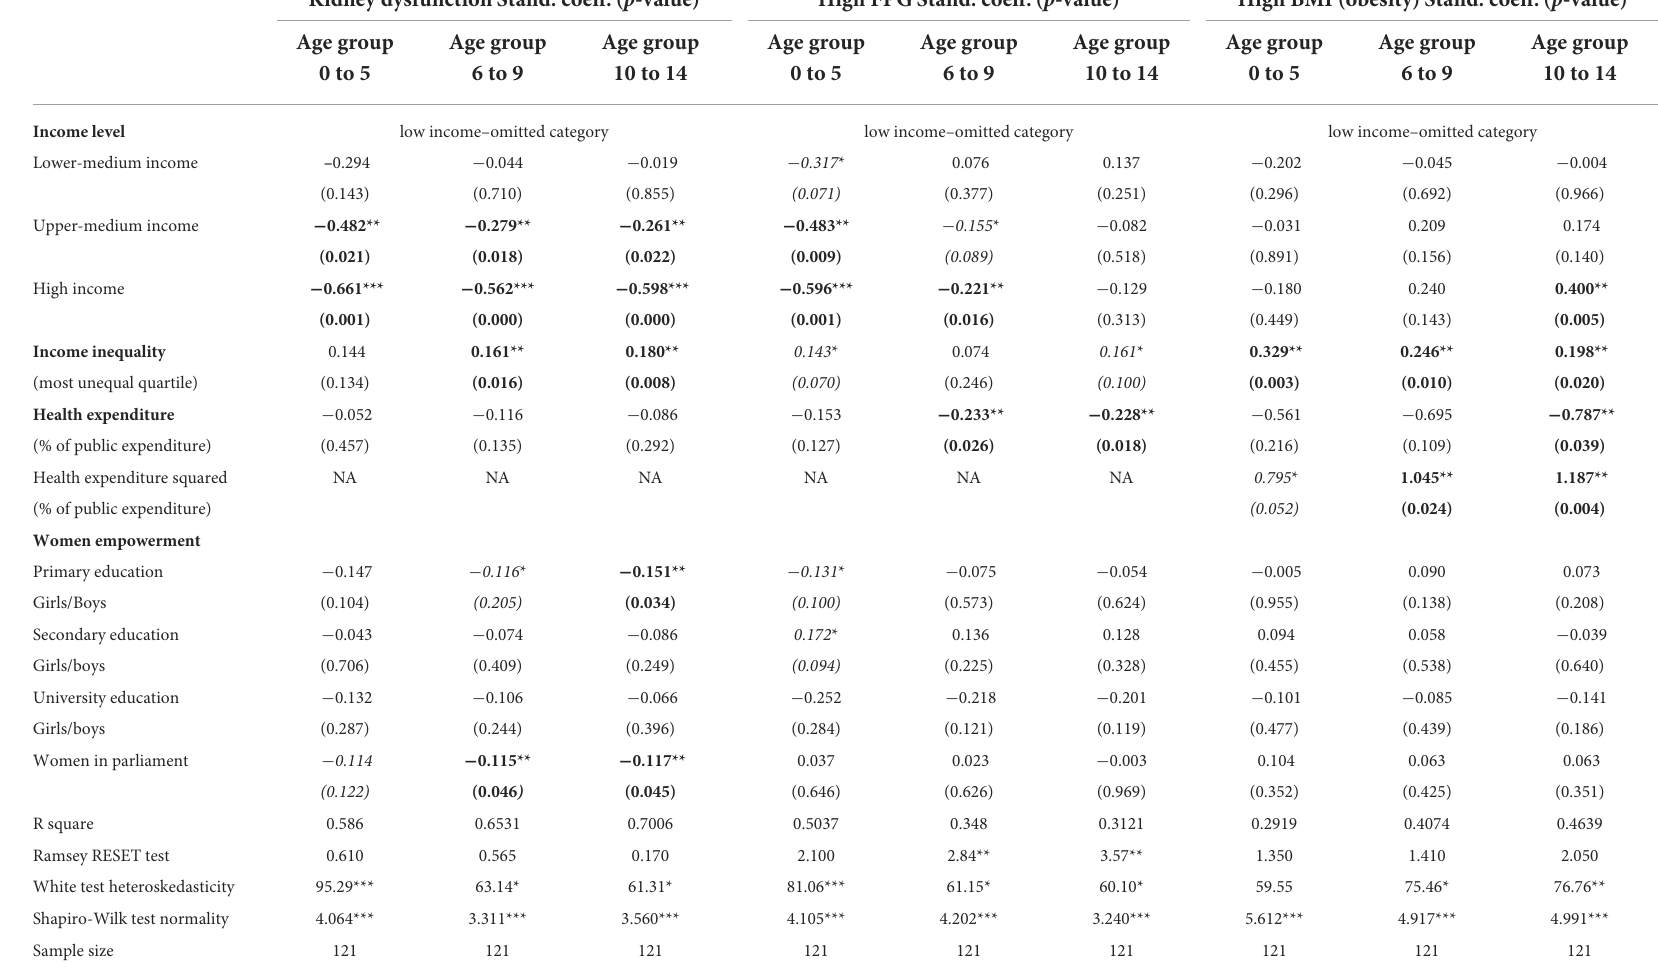
TABLE 2 Model results of the socioeconomic and contextual determinants of DALYs attributable to metabolic risk factors in children. Kidney dysfunction Stand. coeff. ( p